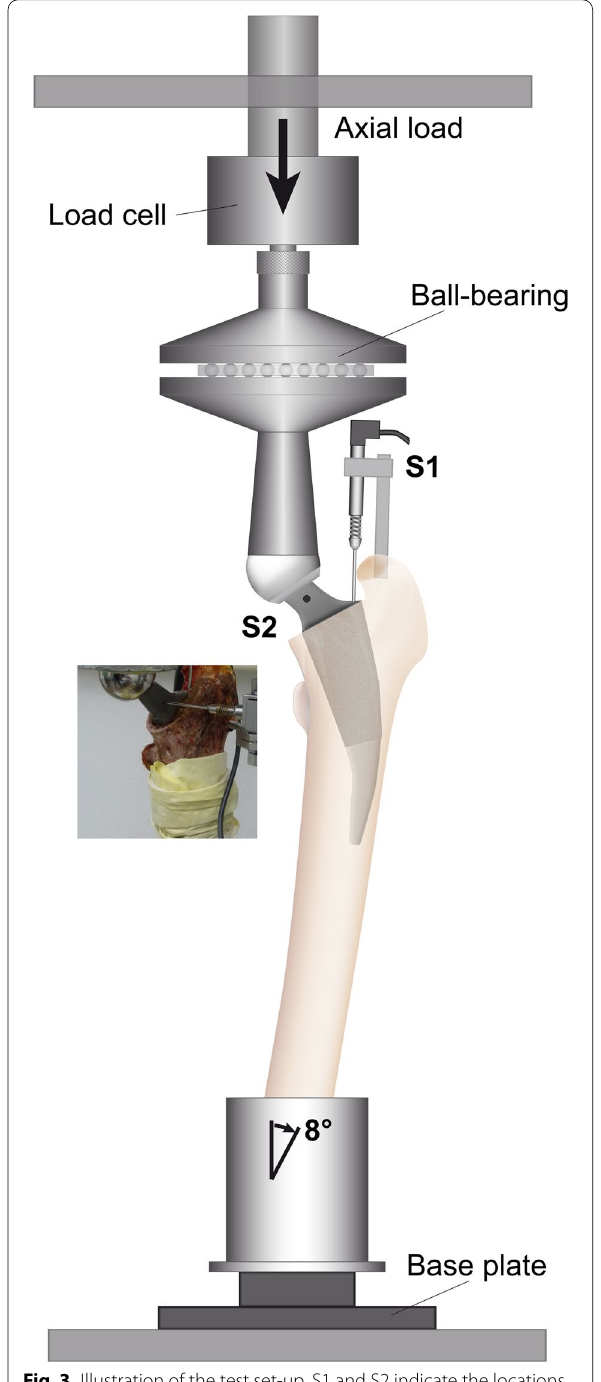
Fig. 3 Illustration of the test set-up. S1 and S2 indicate the locations of the two miniature displacement transducers